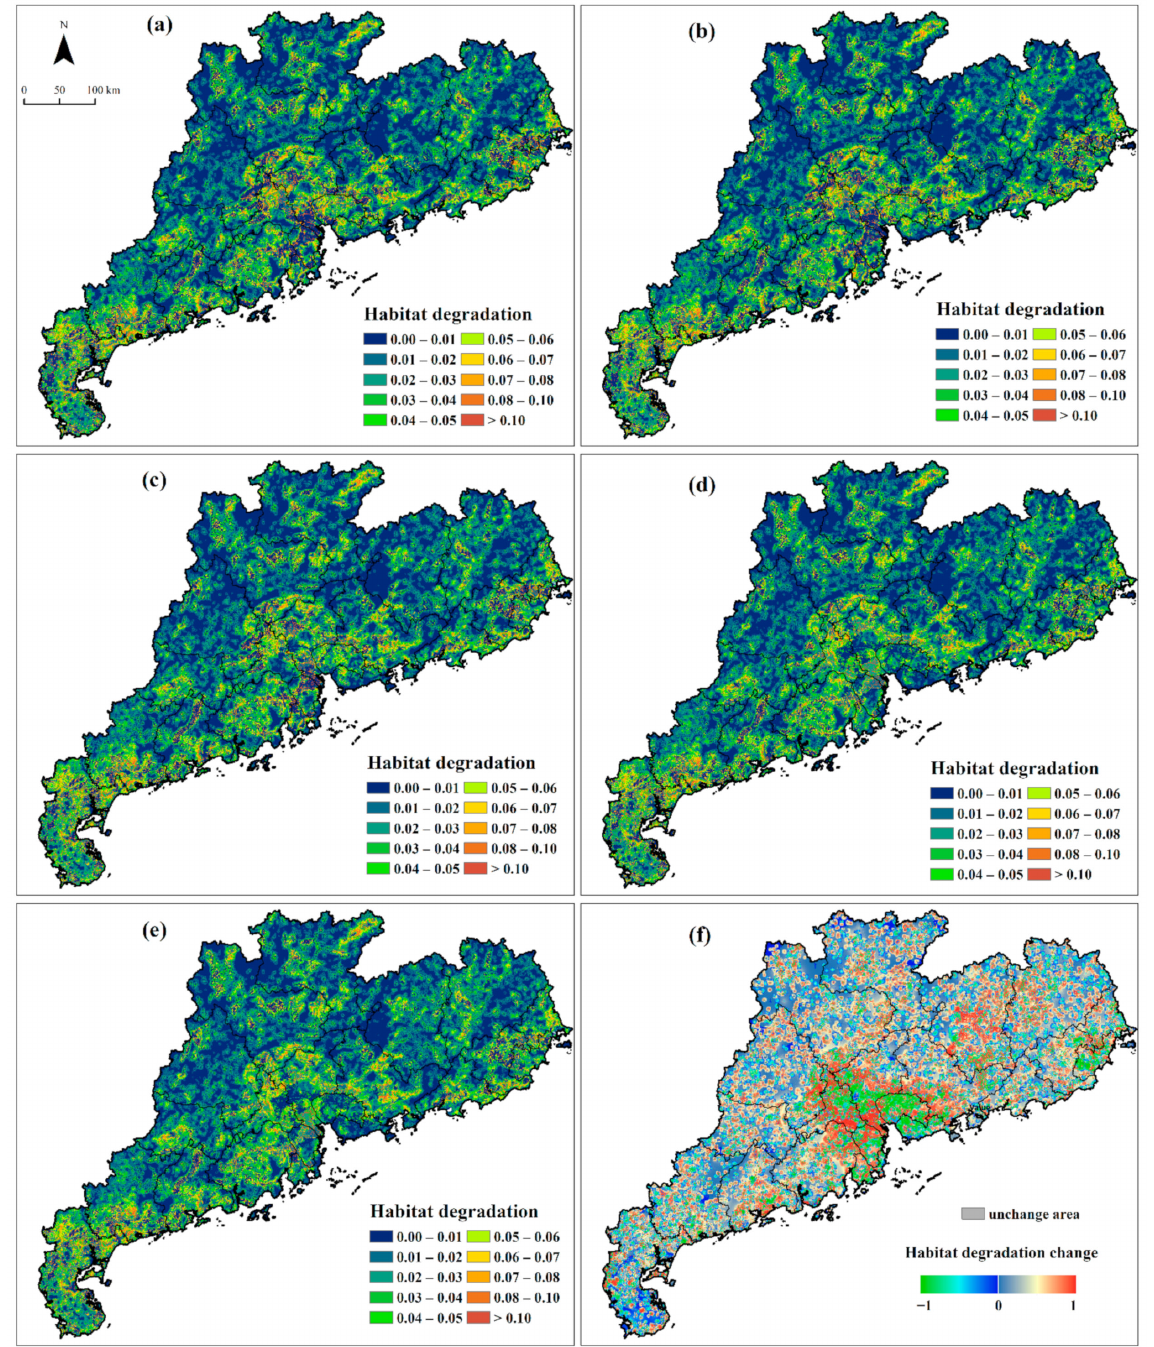
Figure 9. Spatial distribution of habitat degradation in 1980 ( a ), 1990 ( b ), 2000 ( c ), 2010 ( d ), 2020 ( e ) and habitat degradation change from 1980 to 2020 ( f